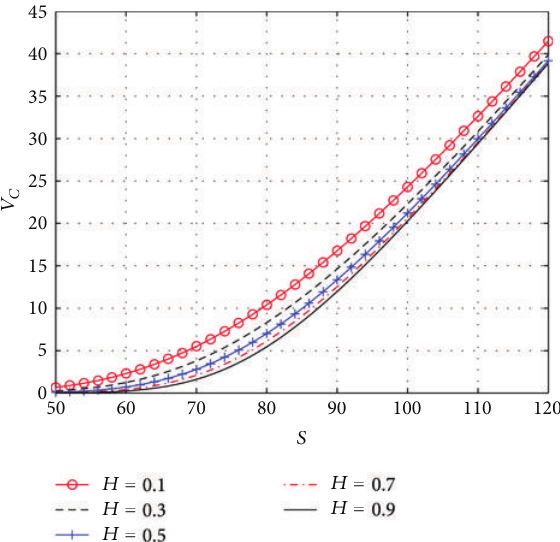
Figure 1: The values of the call option with different 𝐻 .